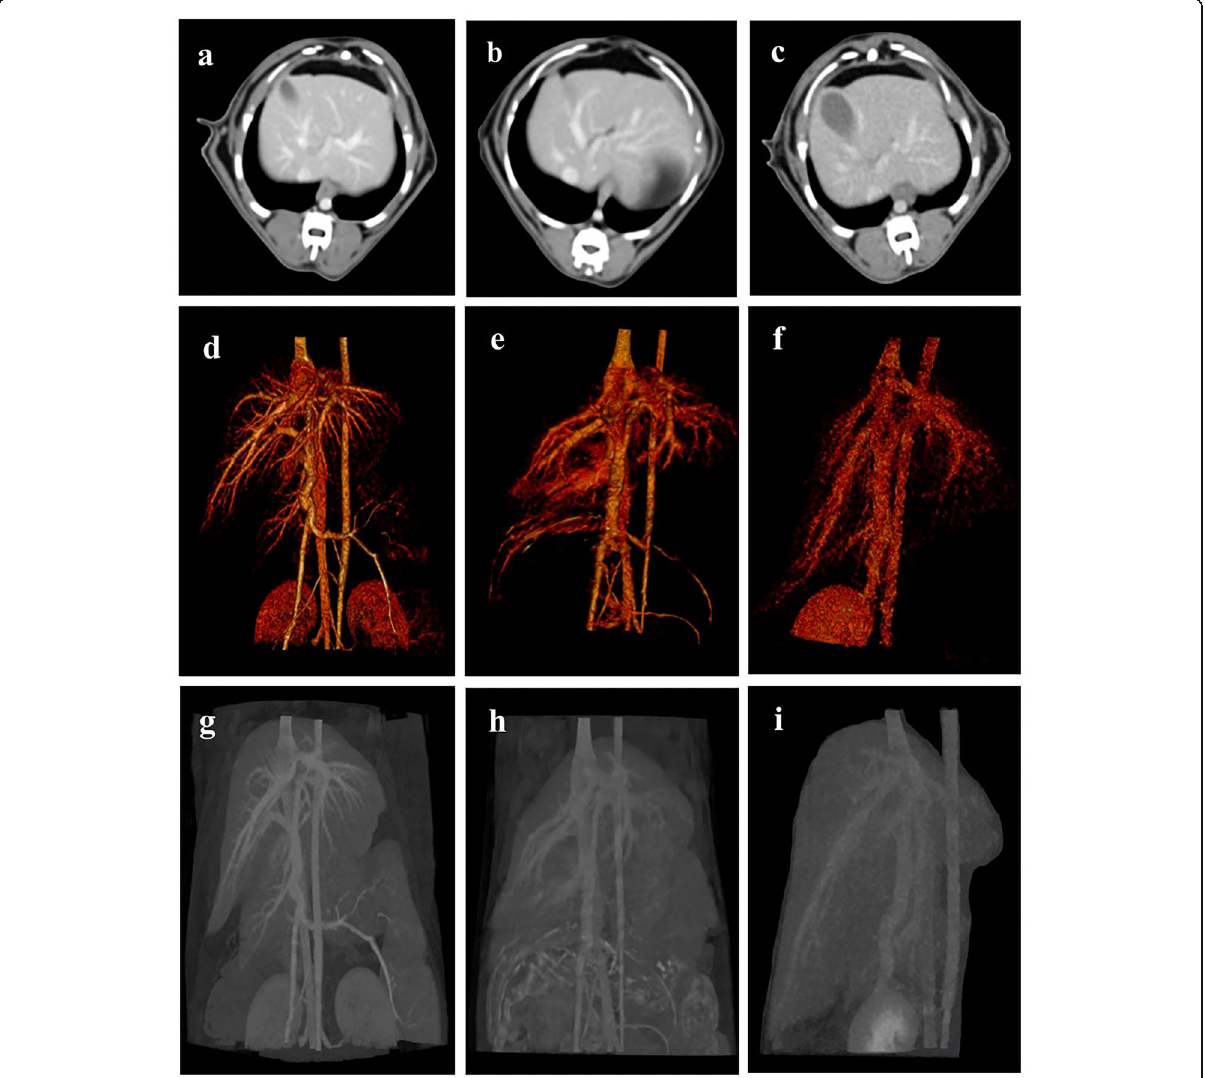
Fig. 4 Triple-phase hepatic CT images of the delay phase at different TDs (60 s, 62 s and 64 s). Hepatic parenchymal phase images at 60 s TD: hepatic transverse CT image ( a ), hepatic vessel VR image ( d ) and MIP image ( g ). Hepatic parenchymal phase images at 62 s TD: hepatic transverse CT image ( b ), hepatic vessel VR image ( e ) and MIP image ( h ). Hepatic parenchymal phase images at 64 s TD: hepatic transverse CT image ( c ), hepatic vessel VR image ( f ) and MIP image ( i ). All images have the same orientation; R is on the left of the